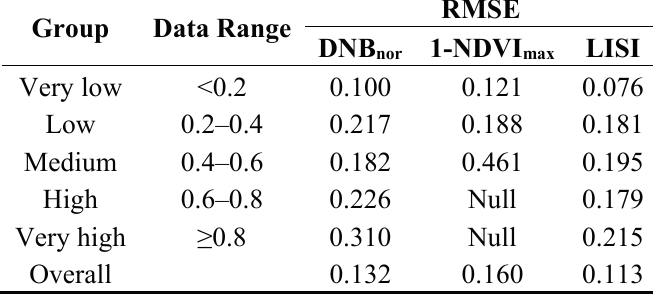
Table 4. Comparison of RMSE results among three estimation approaches at five ISA levels.